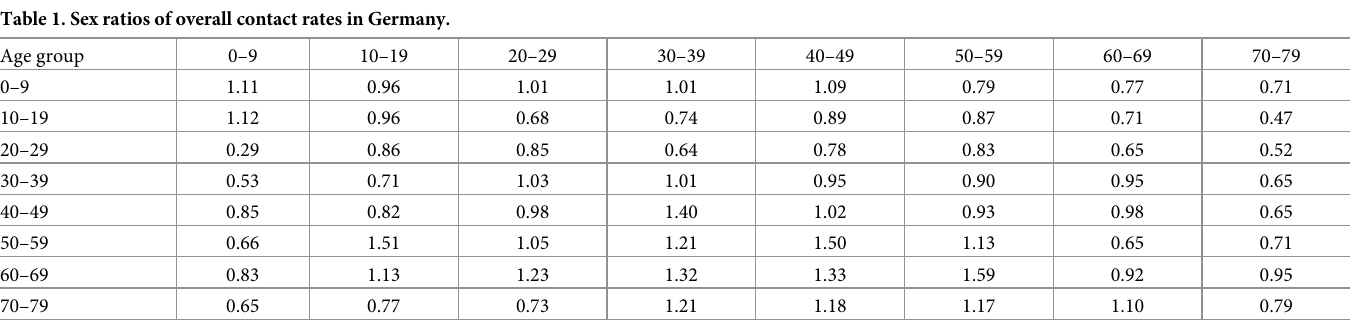
Table 1. Sex ratios of overall contact rates in